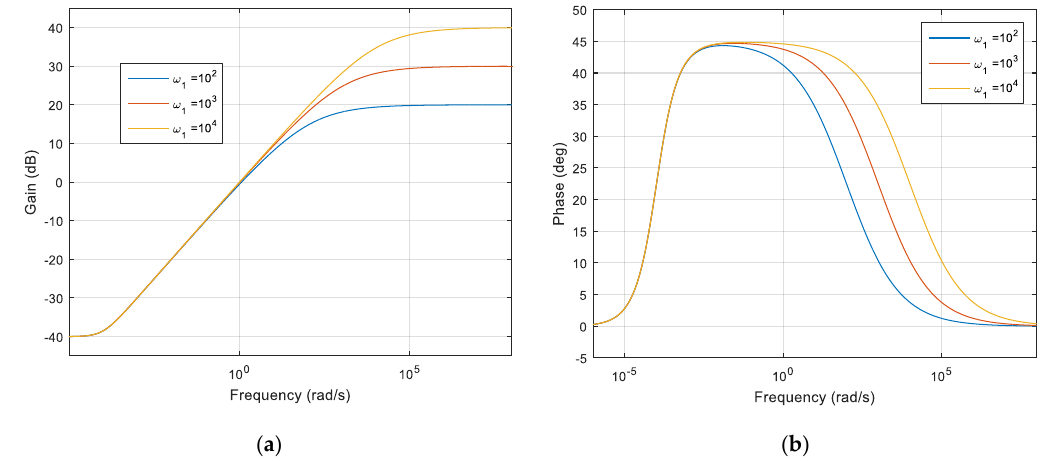
, with ν = 0.5: gain ( a ) and phase ( b ). 1